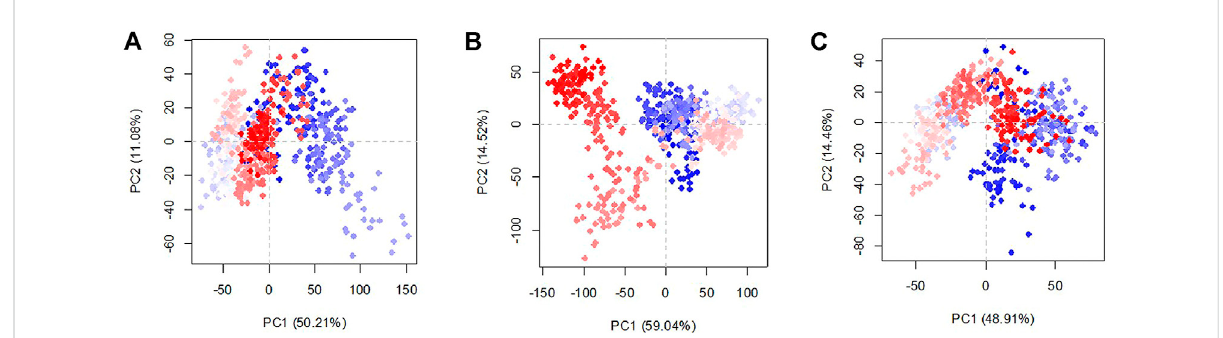
FIGURE 6 Characteristic conformation variance of all systems calculated over 100 ns MD simulations. Shades of red and blue spots present conformational changes. RBDfN, gRBDfN, and gmRBDfN systems are shown in pictures (A) , (B) , and (C) ,